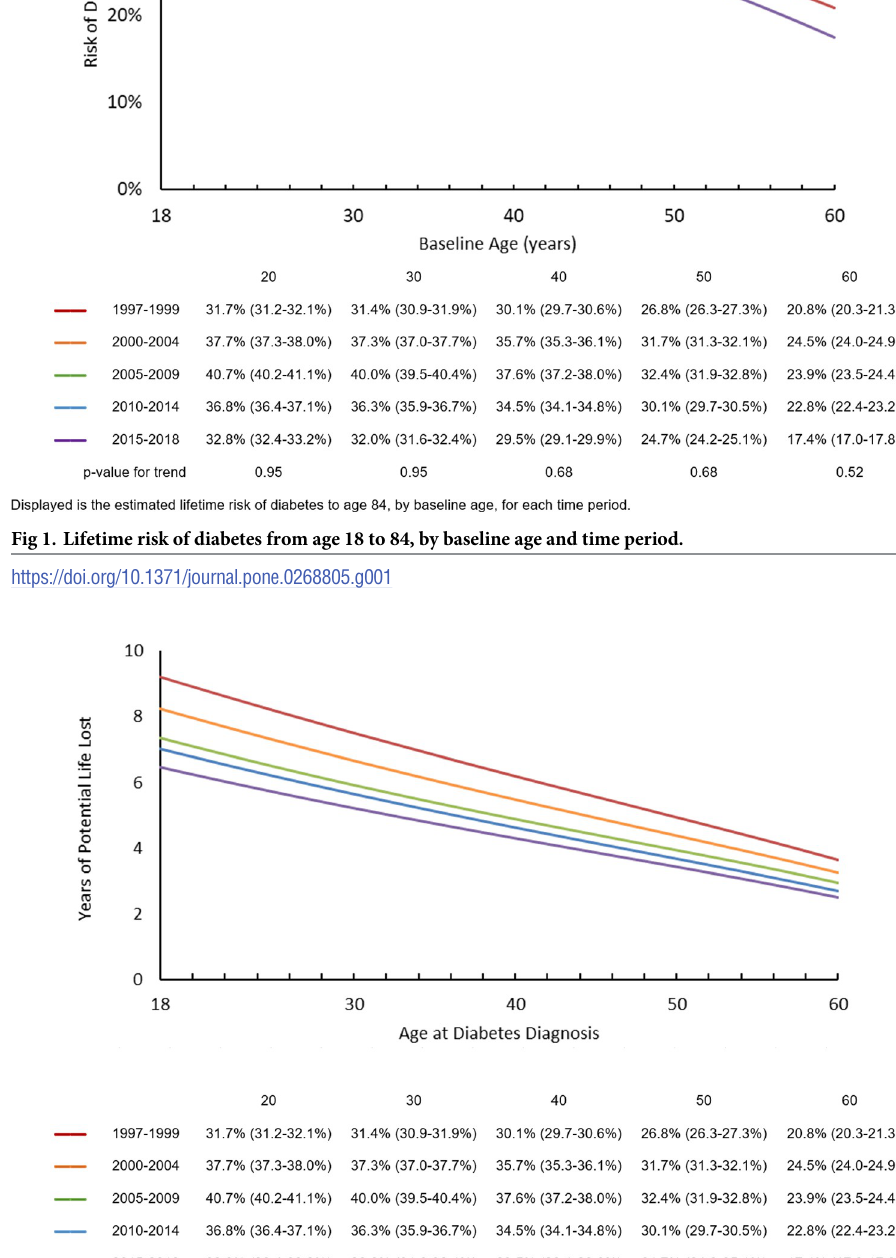
PLOS ONE | https://doi.org/10.1371/journal.pone.0268805 May 24,